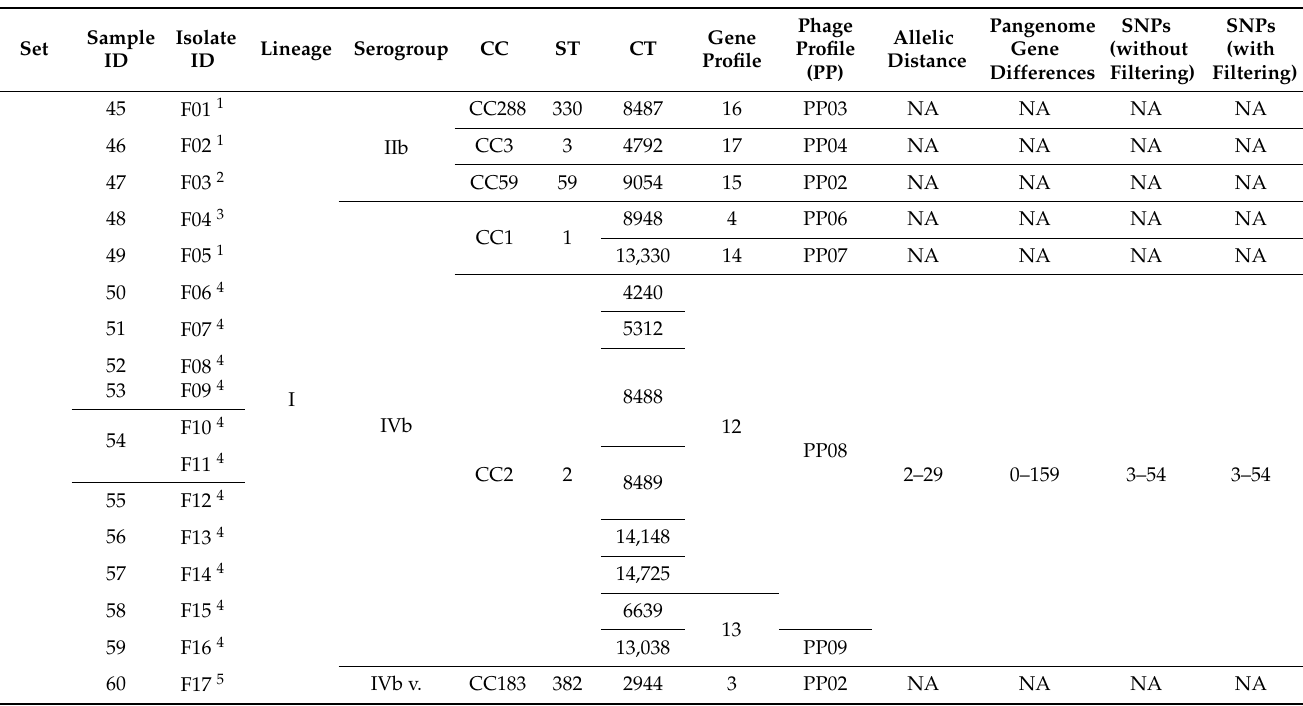
Table 4. Set F isolates obtained from fish-associated samples with indication of typing and screening results as well as the number of differences detected between the isolates by different analysis